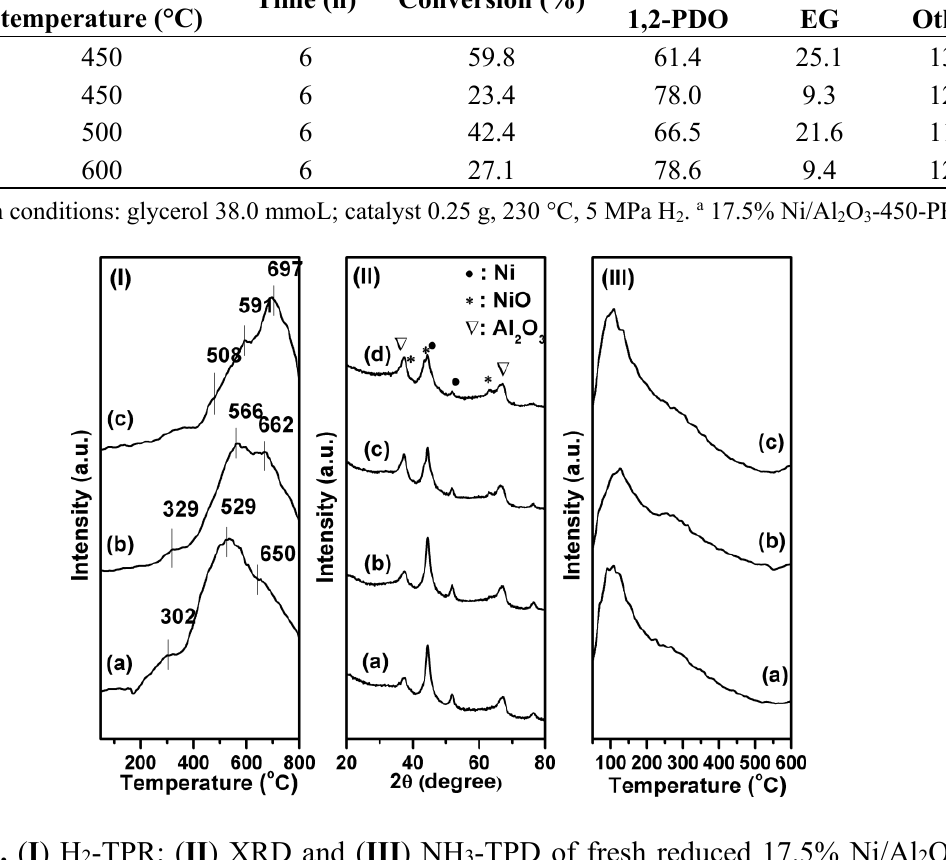
Figure 6. ( I ) H 2 -TPR; ( II ) XRD and ( III ) NH 3 -TPD of fresh reduced 17.5% Ni/Al 2 O 3